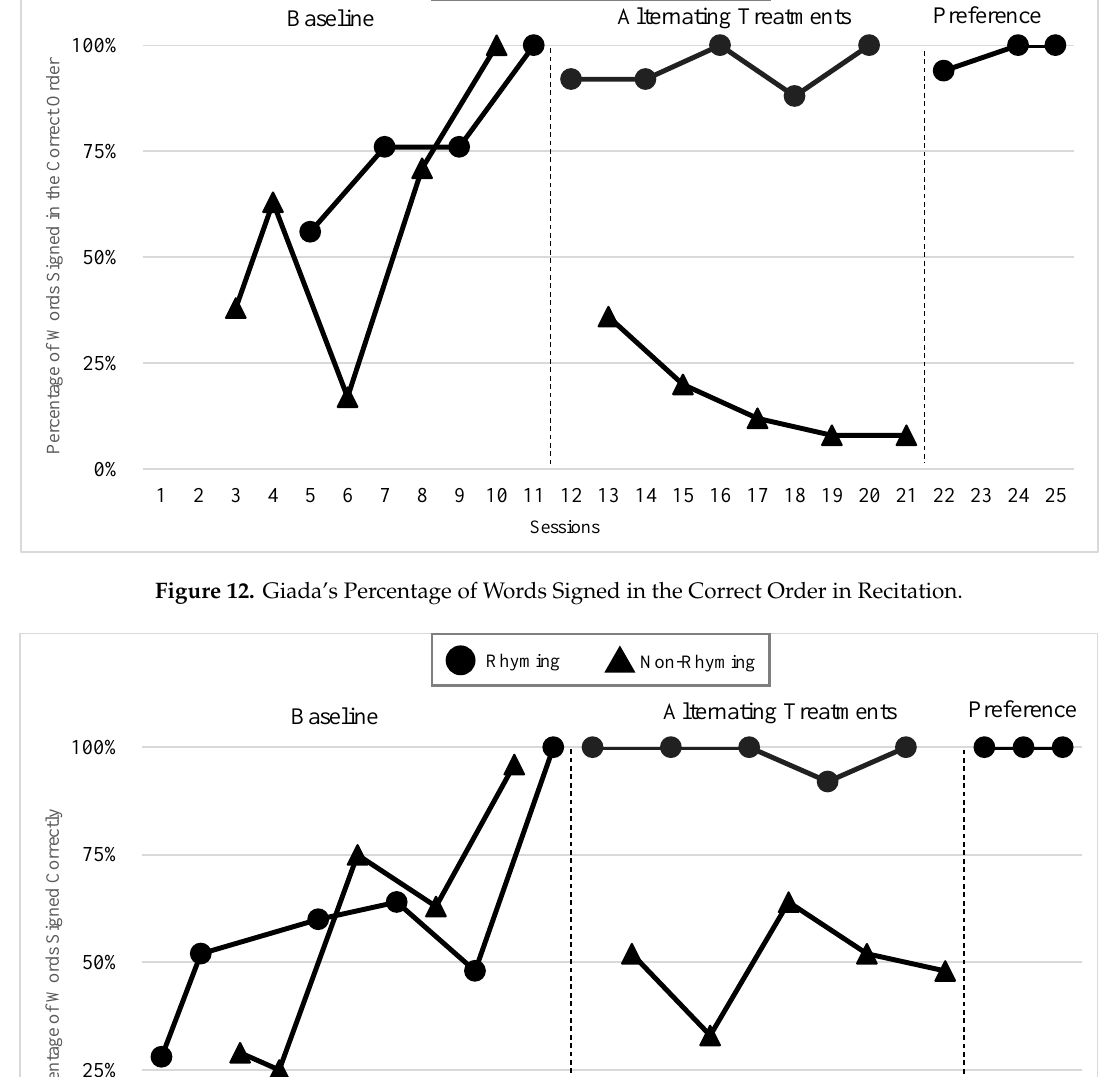
Figure 11. Giada’s Percentage of Words Signed Correctly in Recitation.